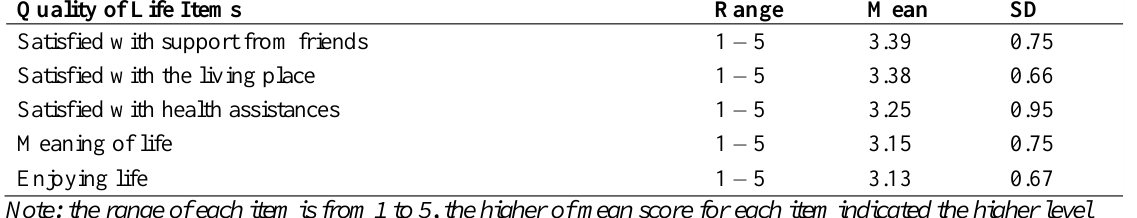
Table 5. Mean and standard deviation of the five top items quality of life Quality of Life Items